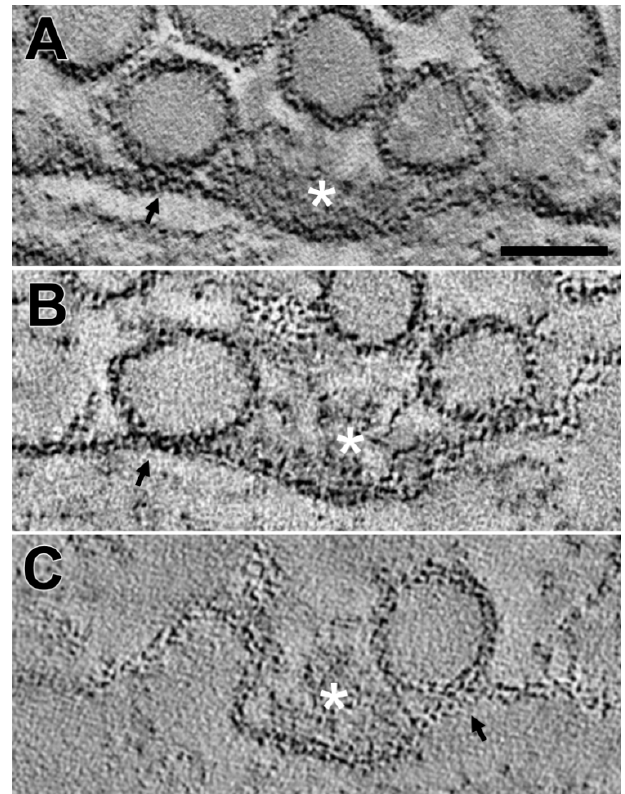
Figure 1. Three docked synaptic vesicles at three different active zones of axon terminals in frog neuromuscular junctions (NMJs), fixed during repetitive electrical nerve stimulation at 10 Hz, evoking synaptic activity. Virtual slices (3.5 nm thick) from three different reconstruction volumes show activated active zones, sectioned nearly in the transverse plane of the active zones. ( A ) The membrane of a synaptic vesicle at an active zone is apposed onto the presynaptic membrane, without any significant merging or gap between the membranes (a black arrow). Opposite to the docked synaptic vesicle, the active zone also has a synaptic vesicle close to the presynaptic membrane. At the active zone, marked by a white asterisk, the densely stained AZM macromolecules are connected to both of the synaptic vesicles. Scale bar = 50 nm. ( B ) A synaptic vesicle at an active zone, which was previously analyzed (See Figure 2E in [45]) is docked with the presynaptic membrane and shows a significant merging with the presynaptic membrane (a black arrow), indicating that the vesicle is hemifused with the presynaptic membrane. Note that the hemifused synaptic vesicle is also connected to the AZM macromolecules. ( C ) A synaptic vesicle at an active zone is docked with the presynaptic membrane, without any significant merging or gap between the membranes (a black arrow). Opposite to the docked synaptic vesicle, the active zone also has a synaptic vesicle completely fusing with the presynaptic membrane. Similar to Figures 2A,B, the AZM macromolecules at the active zone (a white asterisk) are connected to the docked synaptic vesicle and the fusing synaptic vesicle. To quantitatively characterize the spatial relationship of the vesicle membrane to the presynaptic membrane at the contact sites, their 3D surface models were used (Figures 2C,G). The surface models were generated using previously published methods to reliably delineate the contrast boundaries of the membranes and to provide nearly accurate 3D representation of the vesicles and the presynaptic membranes [48,52]. Here, surface models of 81 docked synaptic vesicles and 34 presynaptic membranes were used to obtain the quantitative measurement of their membrane thicknesses, because it is difficult to accurately measure each membrane thickness by manual measurement when relying on individual virtual slices, mainly due to generally varying membrane curvature and irregular membrane staining. The membrane thicknesses of the synaptic vesicles and the presynaptic membranes away from their contact sites were measured using an algorithm (see Materials and Methods and also [45]), by calculating the shortest distances across the membrane between vertices